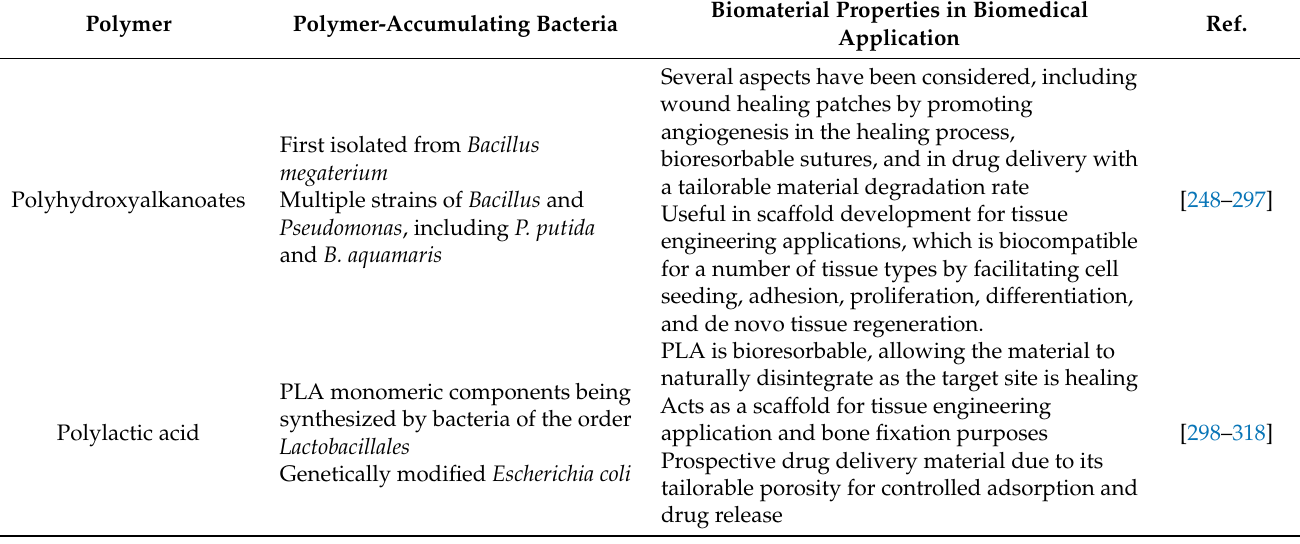
Table 3. Summary Table for Bacteria-Derived